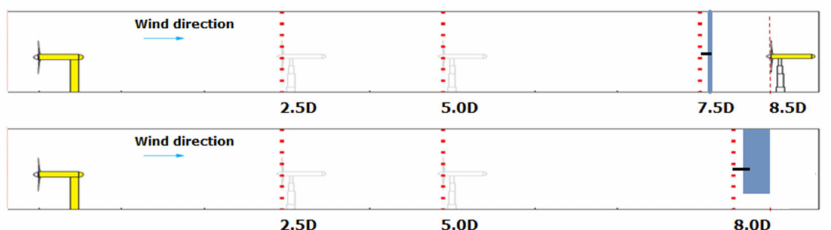
Figure 2. T1 and T2 dimension overview ( top , based on [36]) and measurement plane location of vertical profile conducted by manual traverse ( middle ) and in horizontal profile conducted by automatic traverse ( bottom ).